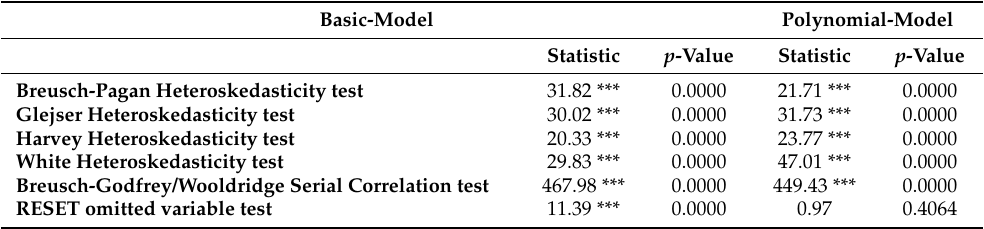
Table 10. Model diagnostic